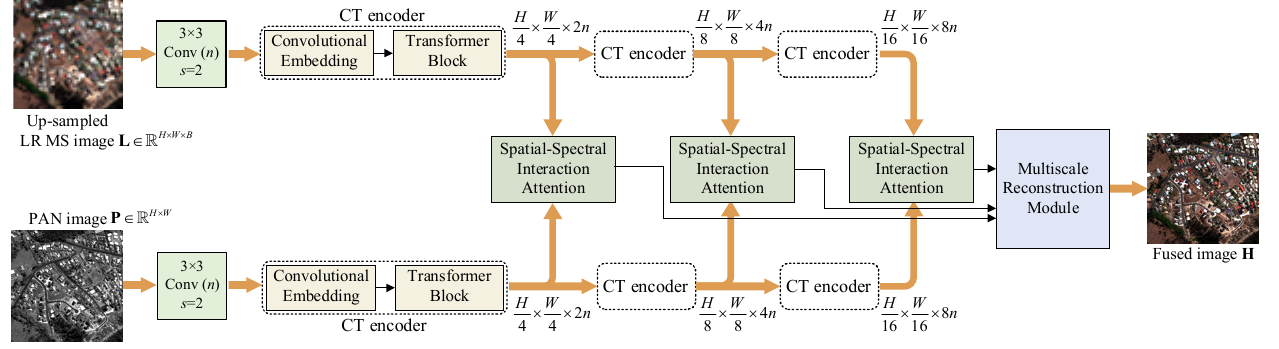
Figure 1. The proposed MSIT framework.